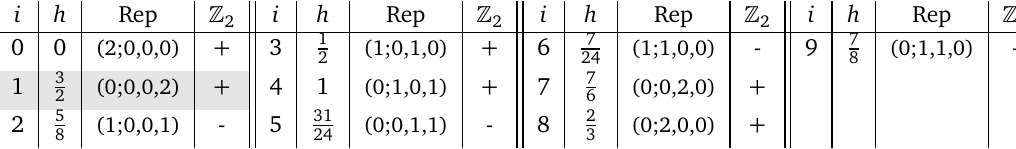
Table 12: Sp ( 6 ) : primaries labeled by i are characterized by weights h and Sp ( 6 ) Dynkin labels. 2 ( τ ) . We highlight the primary related to the center symmetry Their characters are denoted by χ i (cid:90) 2